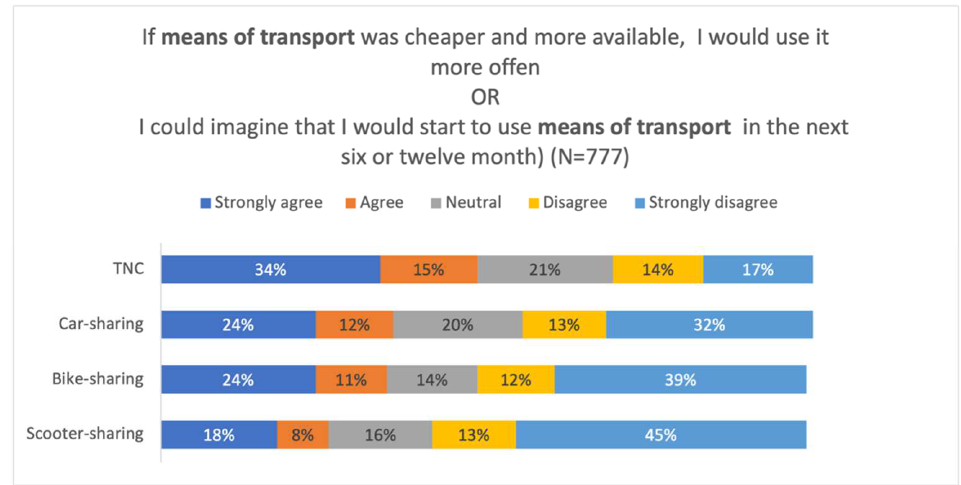
Figure 8. Future intention to use on-demand mobility services in Moscow (N = 777).